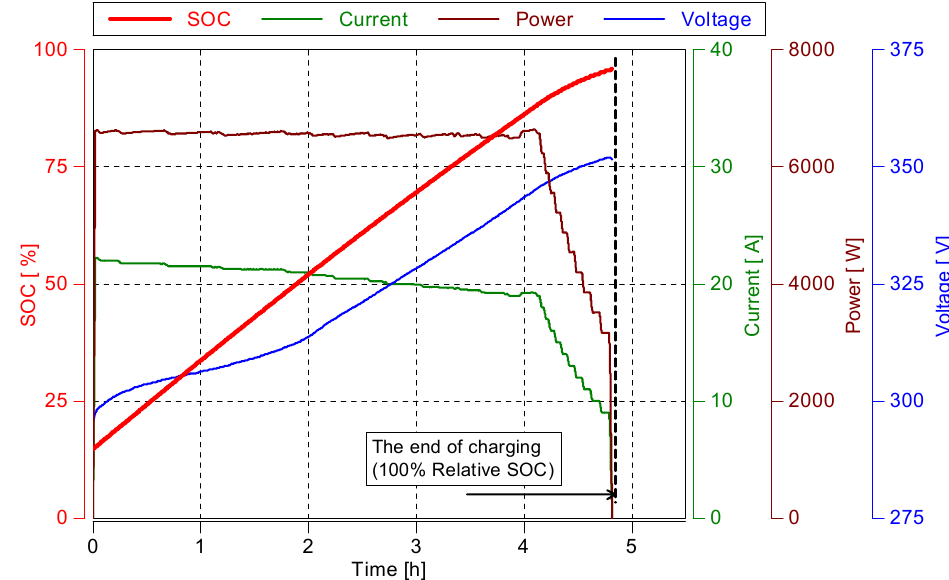
Figure 17. Vehicle charging characteristic for 7.2 kW (AC).